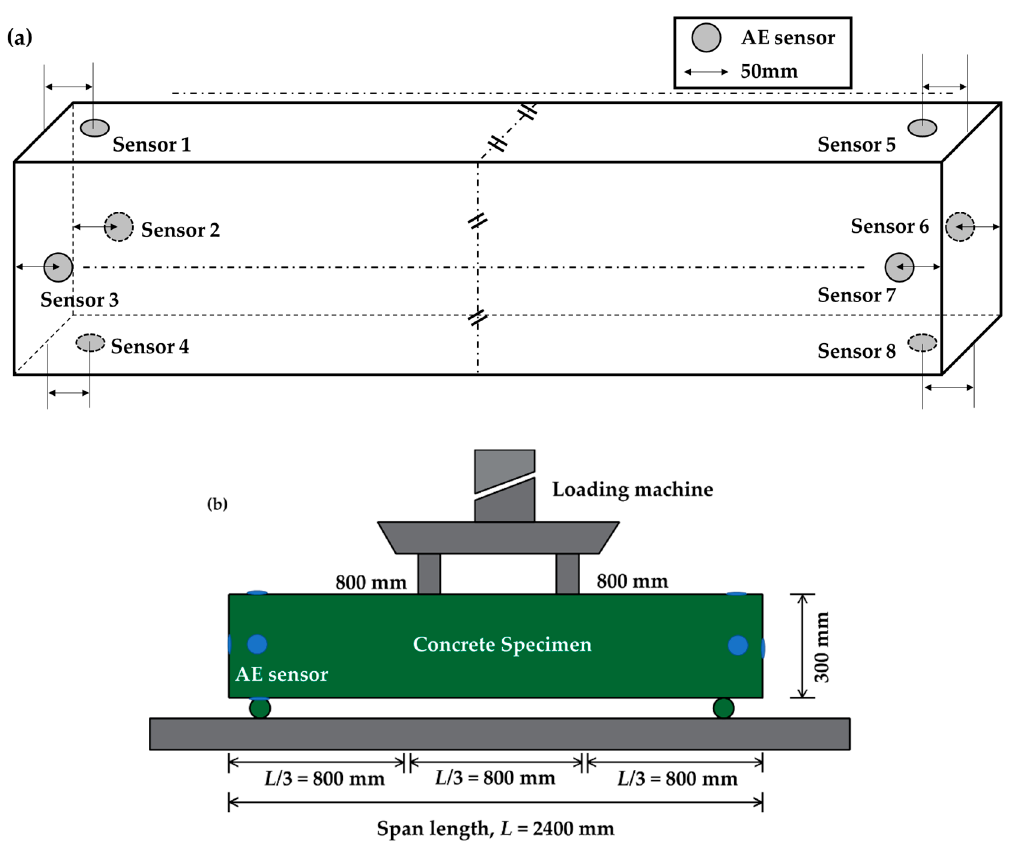
Figure 2. Schematic diagrams of the setup: ( a ) placement of the sensors and ( b ) the flexural test for the concrete beam (three-point bending).